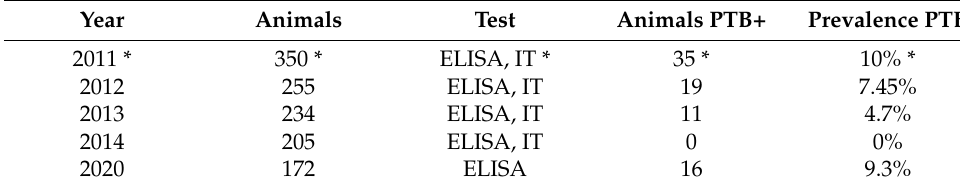
Table 1. Evolution of the PTB prevalence in breeding cattle. Annual diagnostic controls for PTB were carried out by ELISA and IT test from 2012 to 2014. In 2020, only ELISA tests were performed.